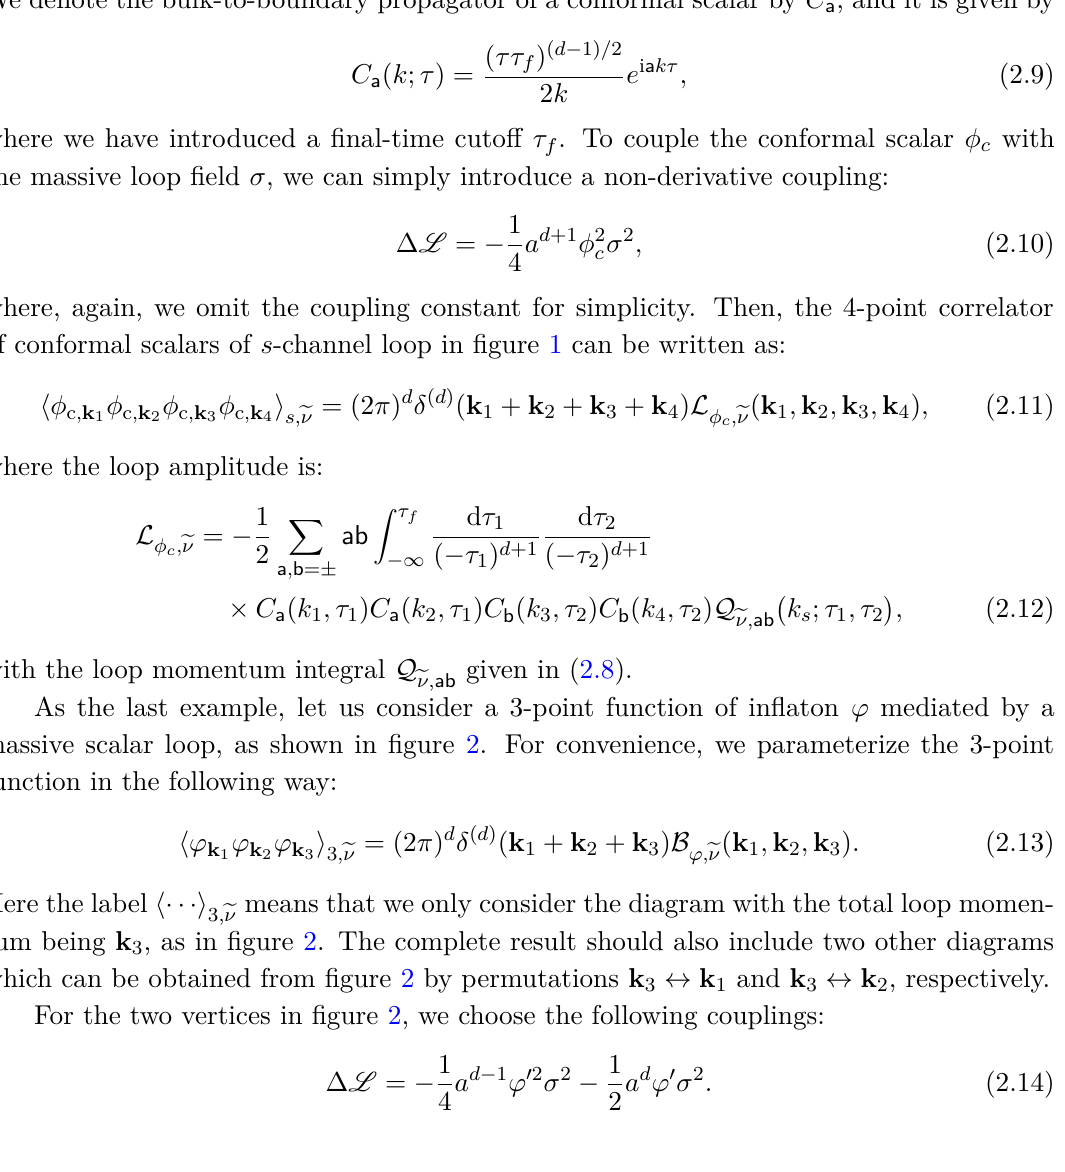
Figure 2 . The 3-point function of inflaton fluctuations ϕ mediated by a massive scalar σ at 1-loop